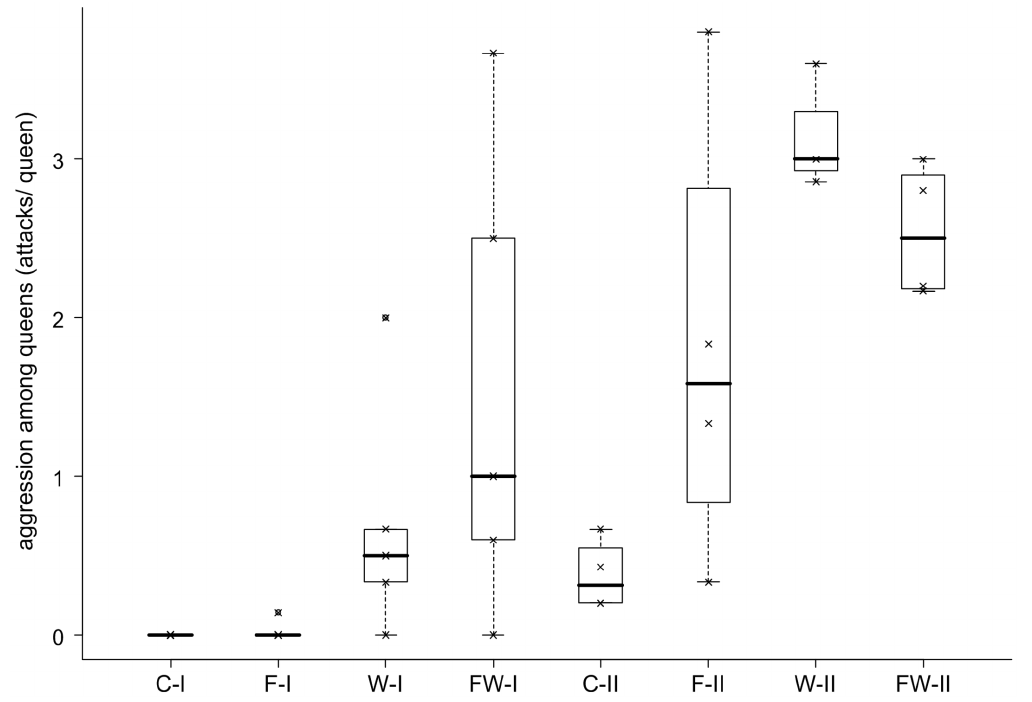
Figure 1. Frequency of aggression among queens of the ant Leptothoraxacervorum from a low-skew population. Data shown as attacks per queen during the total observation period (median, quartiles, range). Individual colonies were subjected to different types of stress (food reduction F, worker reduction W, or both FW) or left unmanipulated (control C) in two different seasons (July, I, and September, II). Outliers are indicated as q and original data points as 6